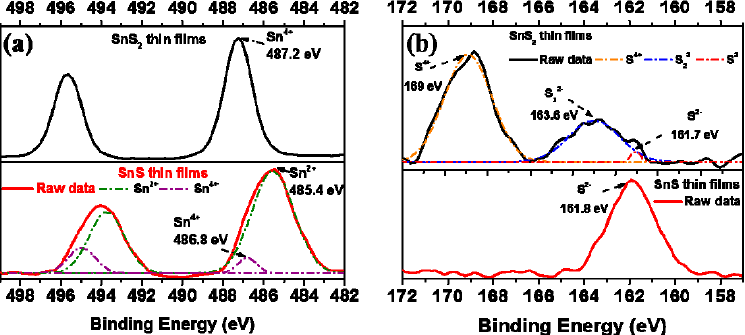
Figure 4. ( a ) ESCA ( electron spectroscopy for chemical analysis ) spectra displays Sn 3d 5/2 and Sn 3d 5/2 peaks at 487.2 eV and 485.4 eV corresponding to Sn 4+ and Sn 2+ of SnS 2 and SnS thin films, respectively; and ( b ) S 2p 3/2 and S 2p 1/2 peaks at 161.8 and 163.6 eV that matches the binding energy of S 2 − and S 22 − of SnS 2 and SnS thin films, respectively.